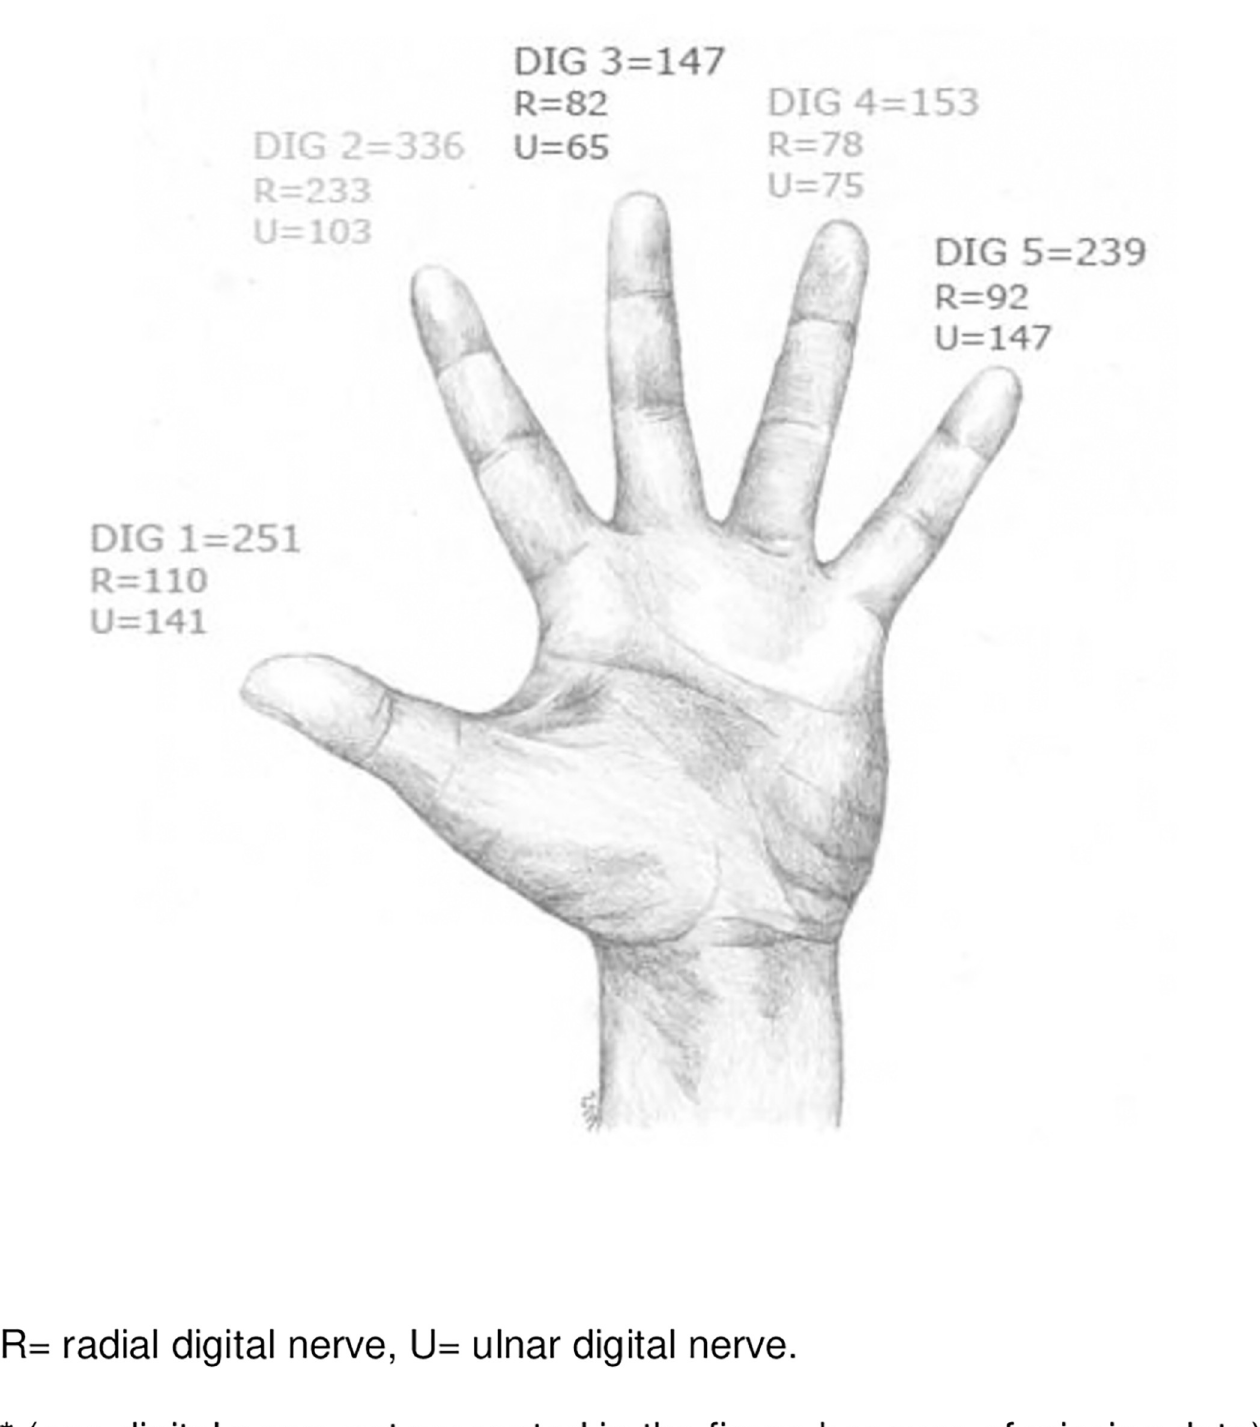
Fig 3. Distribution of 1127 * digital nerve injuries in 1004 patients.